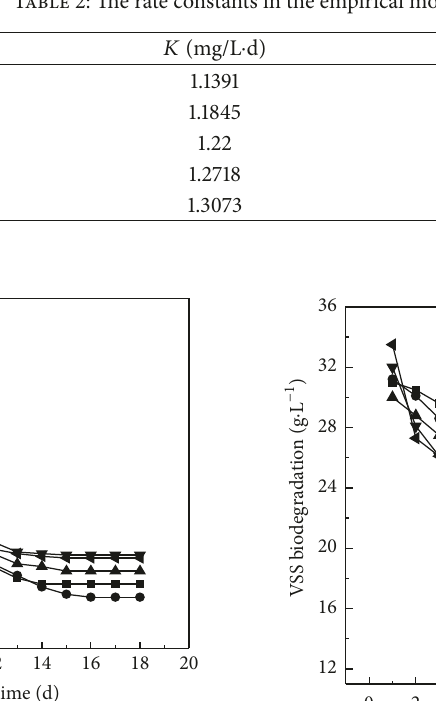
Table 2: The rate constants in the empirical model.